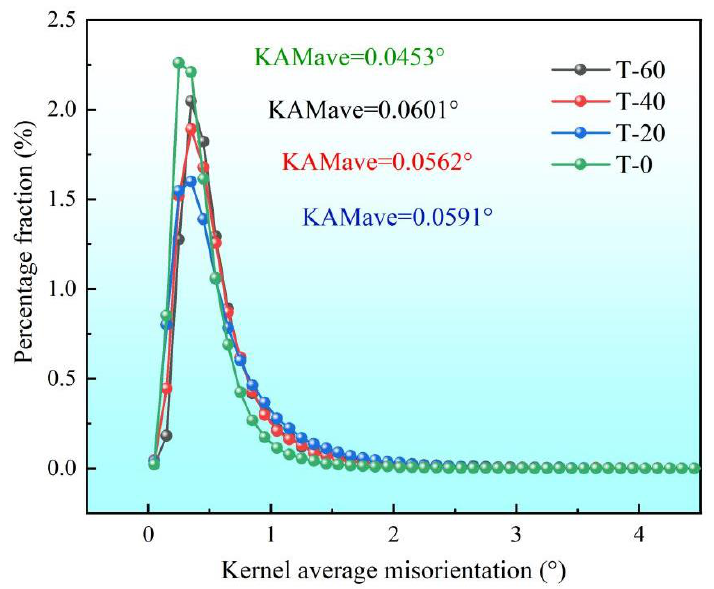
Figure 15. The KAM distribution curves of the LMD-Al 0.5 FeCoCrNi walls under different heat dissipation rates.